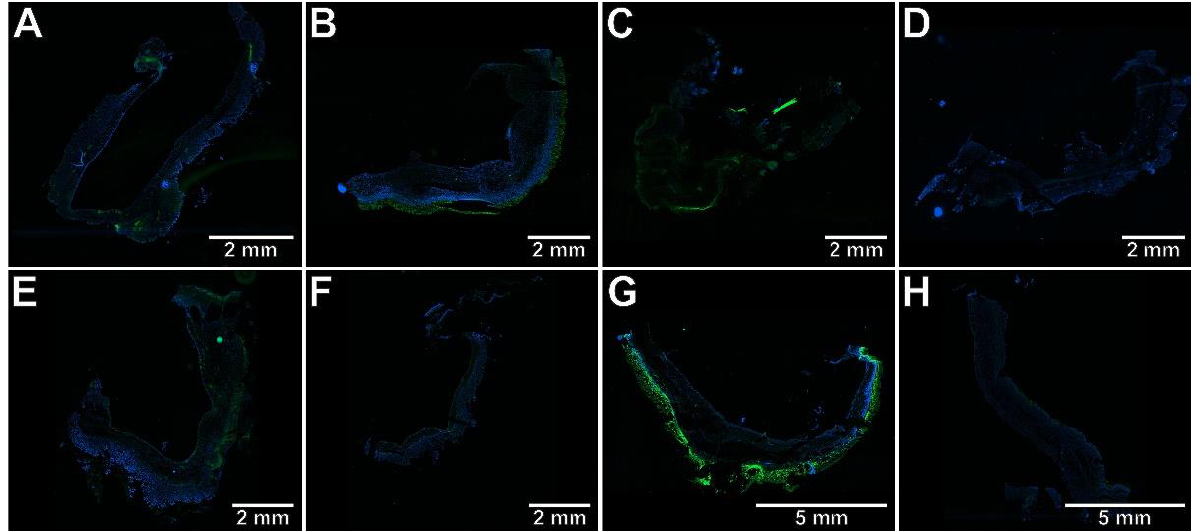
Figure 7. The photomicrographs of cryosections of the whole colon tissue samples after immunostaining with antibodies specific to Foxp3 fluorescently detected demonstrated that only compound 10b counteracted TNBS-induced decrease in Foxp3 expression. Control group ( A ); group receiving only TNBS ( E ); group receiving 10 mg/kg compound 7b and TNBS ( B ); group receiving 20 mg/kg compound 7b and TNBS ( F ); group receiving 10 mg/kg compound 10b and TNBS ( C ); group receiving 20 mg/kg compound 10b and TNBS ( G ); group receiving 10 mg/kg compound 13b and TNBS ( D ); group receiving 20 mg/kg compound 13b and TNBS ( H ); magnification 4×.